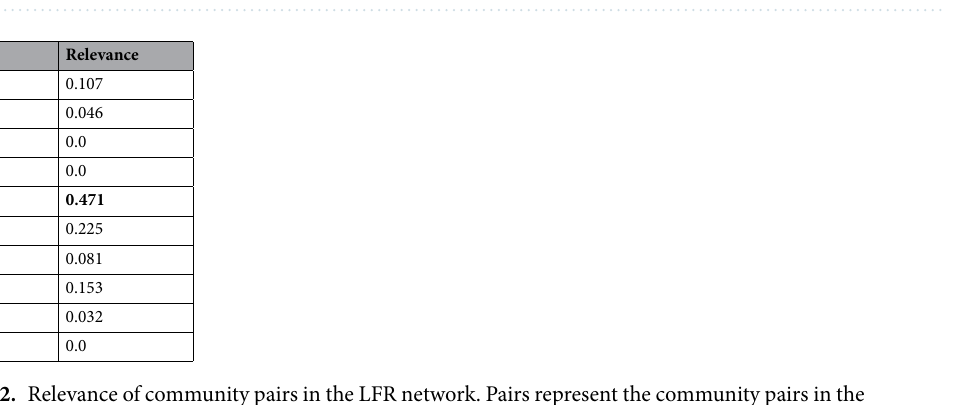
Table 2. Relevance of community pairs in the LFR network. Pairs represent the community pairs in the network and are indicated by their IDs.